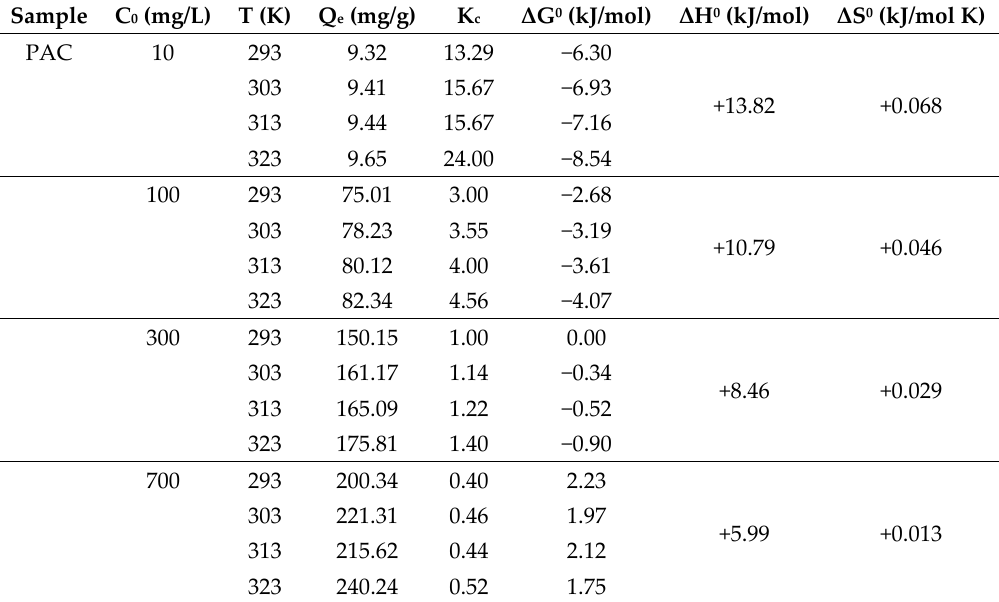
Table 2. Thermodynamic parameters for the adsorption of Pb(II) onto